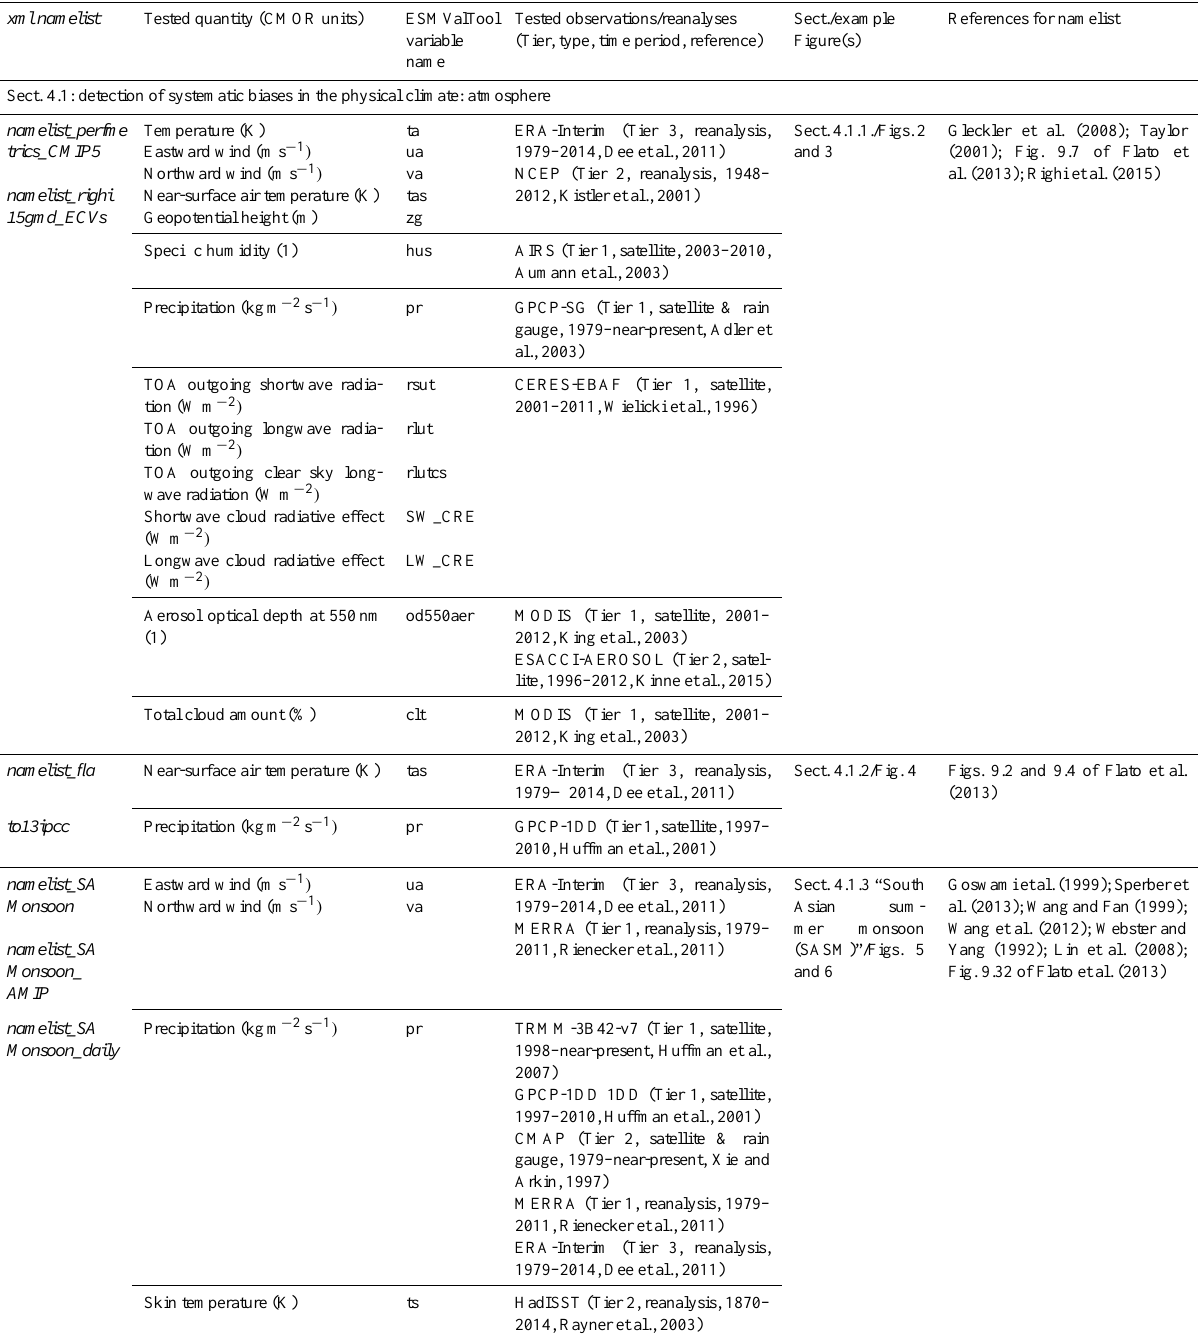
Table 1. Overview of standard namelists implemented in ESMValTool (v1.0) along with the quantity and ESMValTool variable name for which the namelist is tested, the corresponding observations or reanalyses, the section and example figure in this paper, and references for the namelist. When the namelist is named with a specific paper (naming convention: namelist_SurnameYearJournalabbreviation.xml ), it can be used to reproduce in general all or in some cases only a subset of the figures published in that paper. Otherwise the namelists group a set of diagnostics and performance metrics for a specific scientific topic (e.g. namelist_aerosol_CMIP5.xml ). Observations and reanalyses are listed together with their Tier, type (e.g. reanalysis, satellite or in situ observations), the time period used, and a reference. Tier 1 includes observations from obs4MIPs or reanalyses from ana4MIPs. Tier 2 and tier 3 indicate freely available and restricted data sets, respectively. For these observations, reformatting routines are provided to bring the original data in the CF/CMOR standard format so that they can directly be used in the ESMValTool.